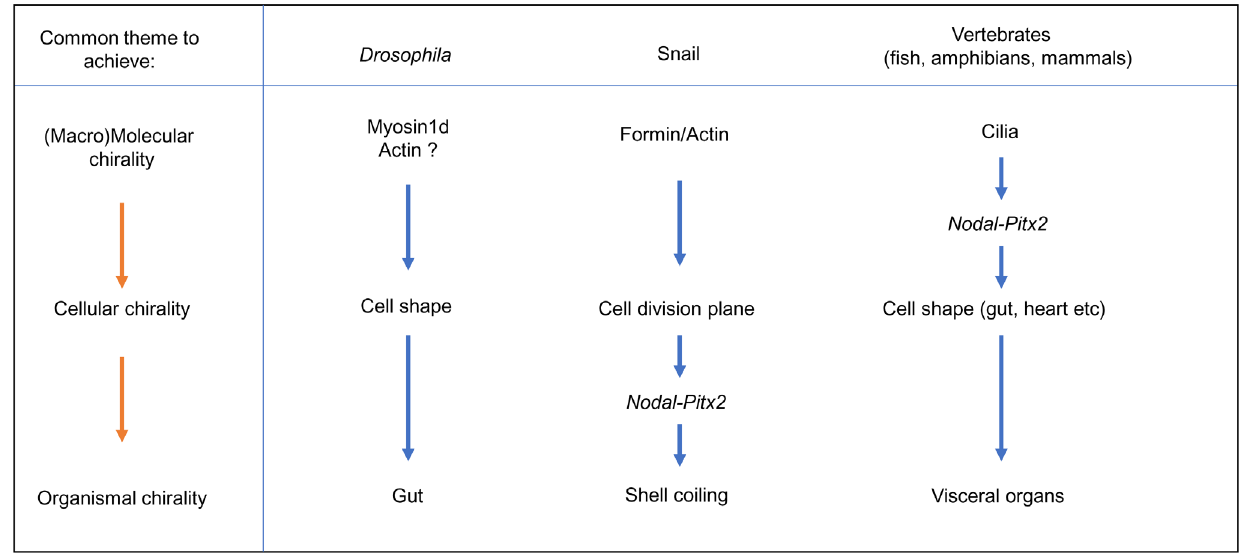
Figure 2. Distinct mechanism of the specification of left-right asymmetry of organs and whole organism in Drosophila , snails, and vertebrates. Note that different animal species use variations of the common theme (in the left-hand box) to establish L-R asymmetry. See the text for